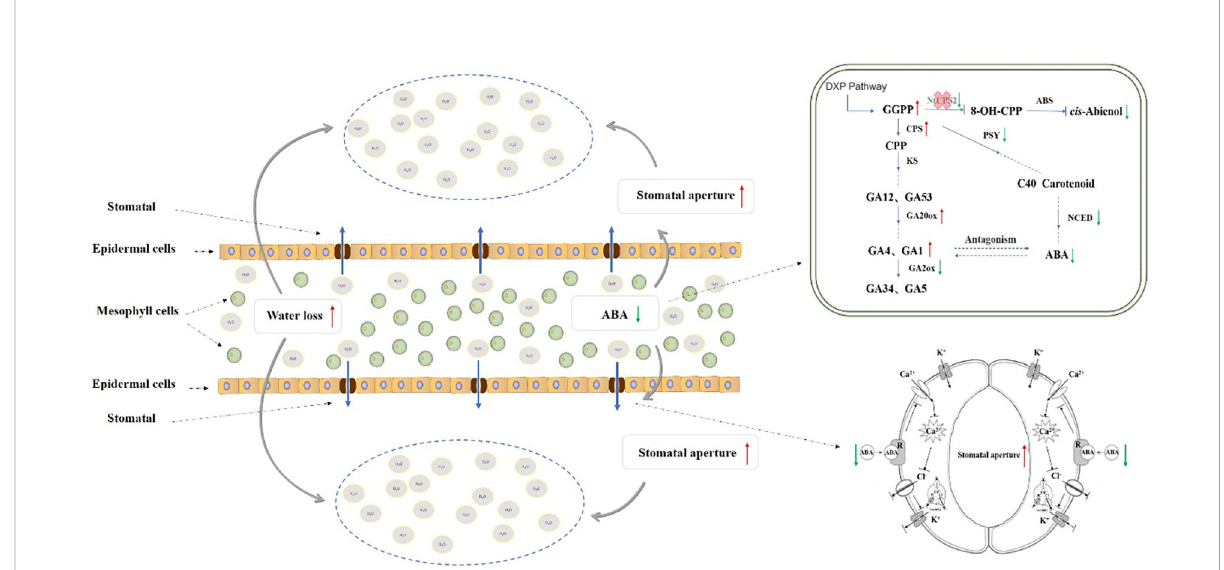
FIGURE 9 Metabolic network of the effect of NtCPS2 gene on drought resistance in